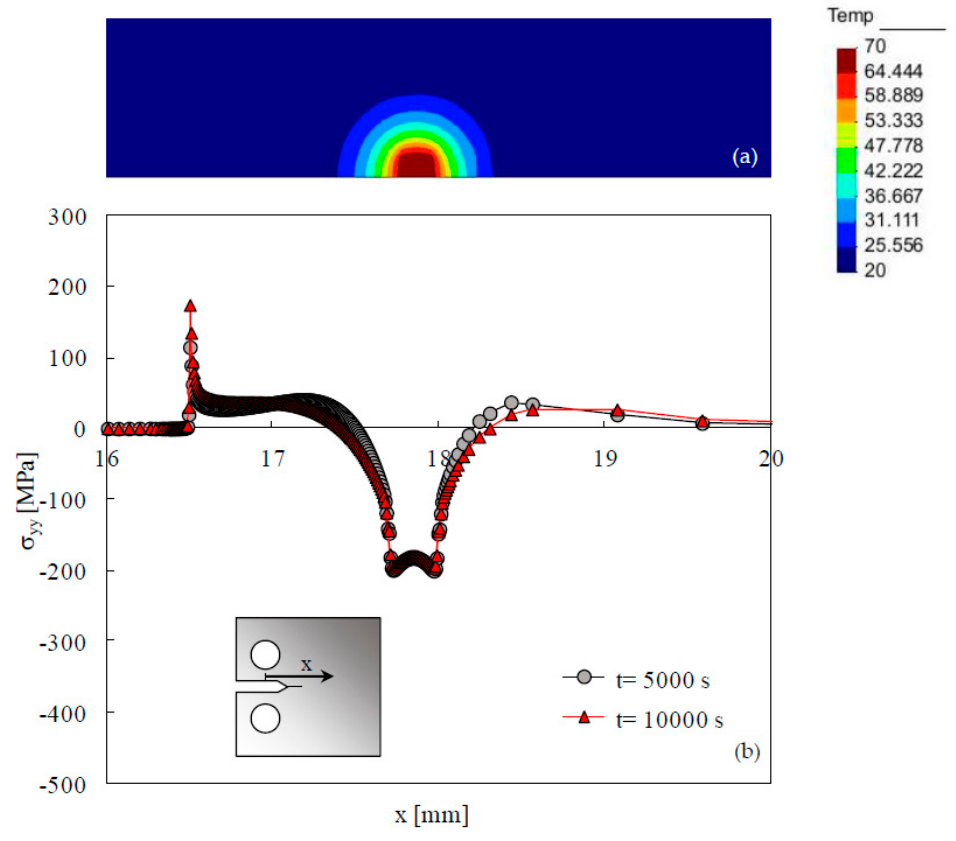
Figure 2. ( a ) Temperature field for t = 10,000 s. ( b ) Distribution of thermal residual stresses in the elastic regime at the symmetry line for two different instants ( a = a 0 = 16.5 mm). Figure 4 plots the profiles of residual stresses obtained with the plastic deformation.